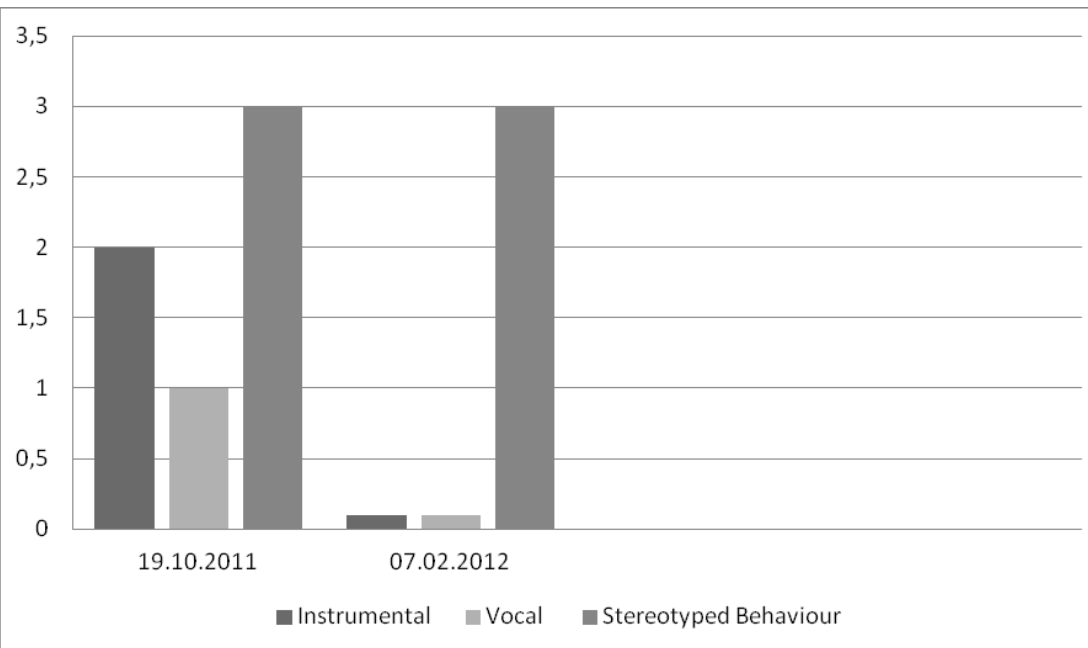
Source: Chart based on Scale II Musical Communicativeness Rating Form (Nordoff, Robbins, 2007, p. 417). Fig. 4 Evoked responses (a nine-year-old boy)